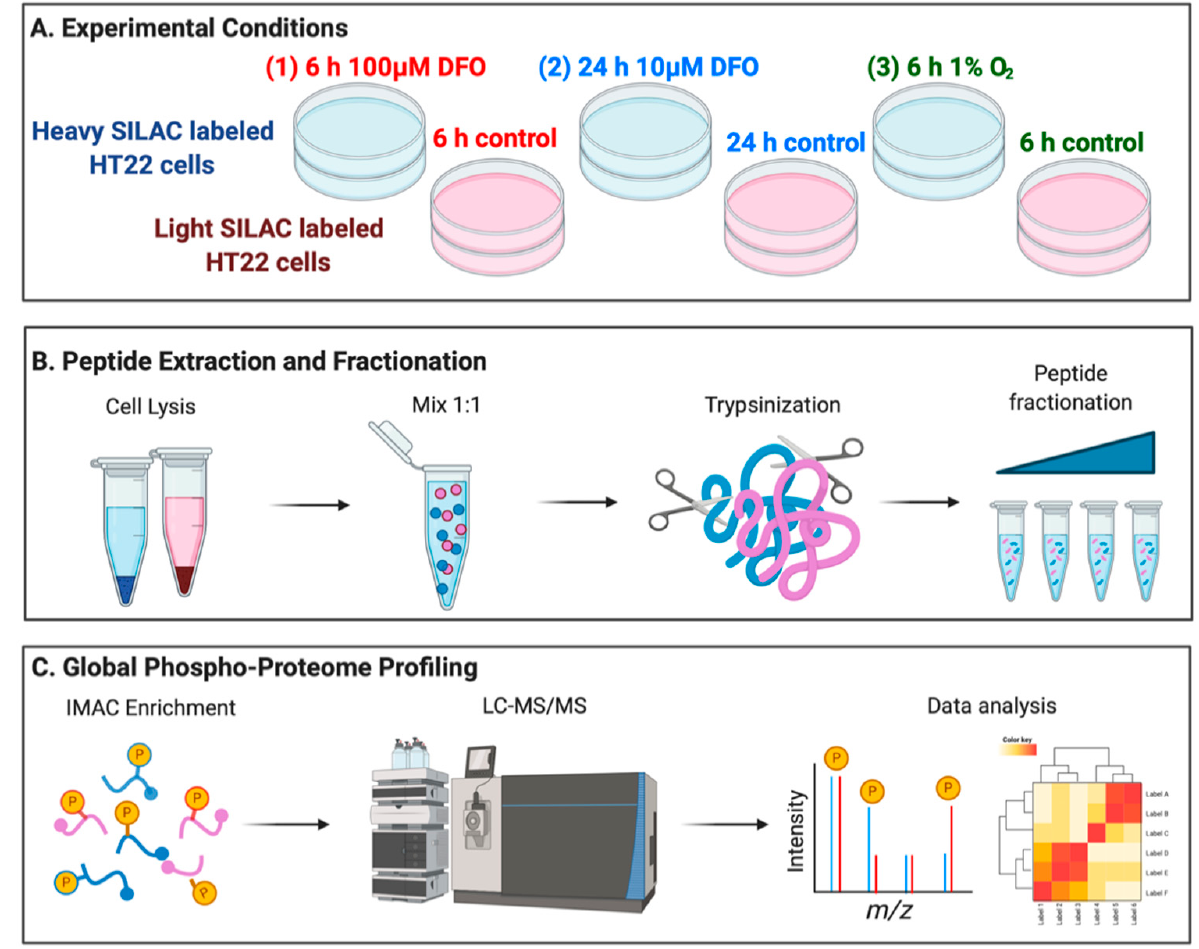
Figure 2. Experimental design and phosphoproteomic workflow for comprehensive analysis of phosphorylation proteome. ( A ) Outline of experimental workflow using Stable Isotopic Labeling of Amino acids in Cell culture (SILAC)-labeled HT22 cells, ( B ) generating peptides for quantification, and ( C ) enrichment of phospho-sites, mass spectrometry acquisition, and data analysis.